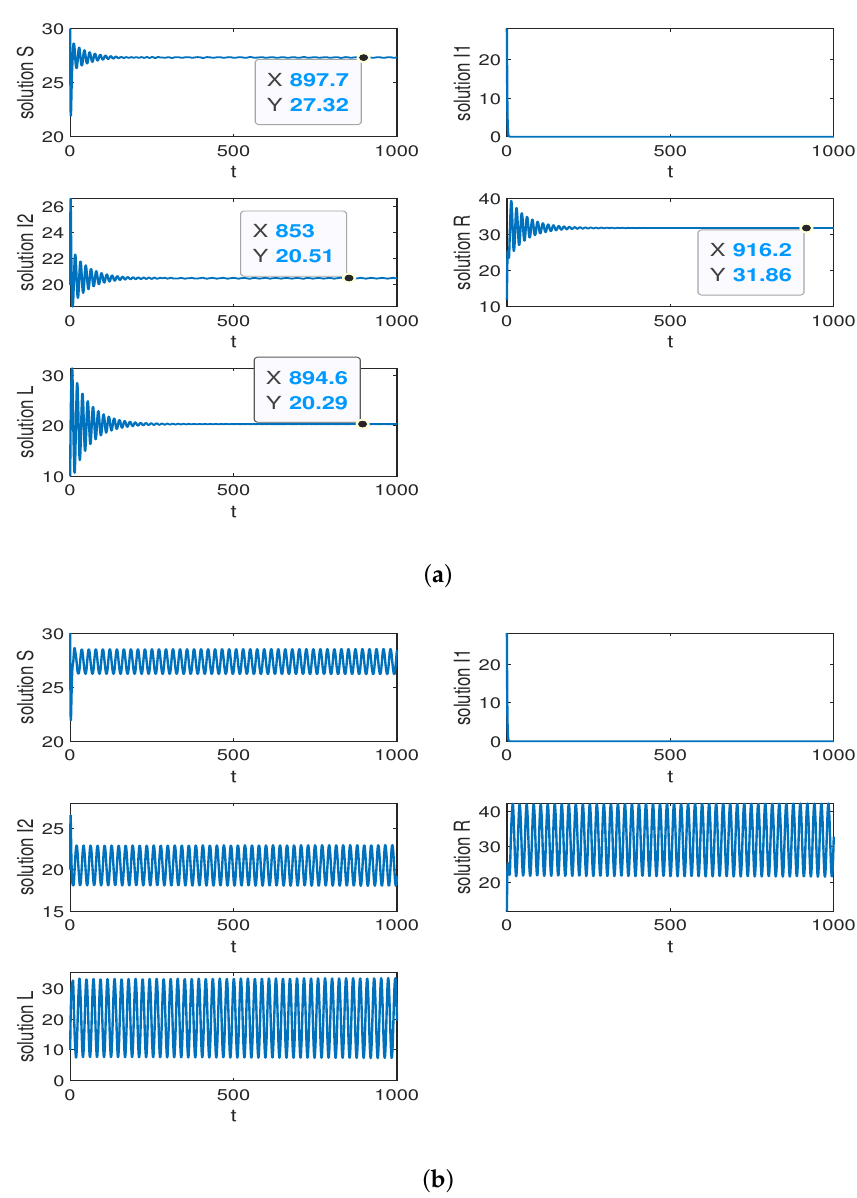
Figure 4. The variation diagram of state nodes. ( a ) The variation in the state nodes when τ = 5.891 < τ 20 = 8.4822. ( b ) The variation in the state nodes when τ = 8.4922 > τ 20